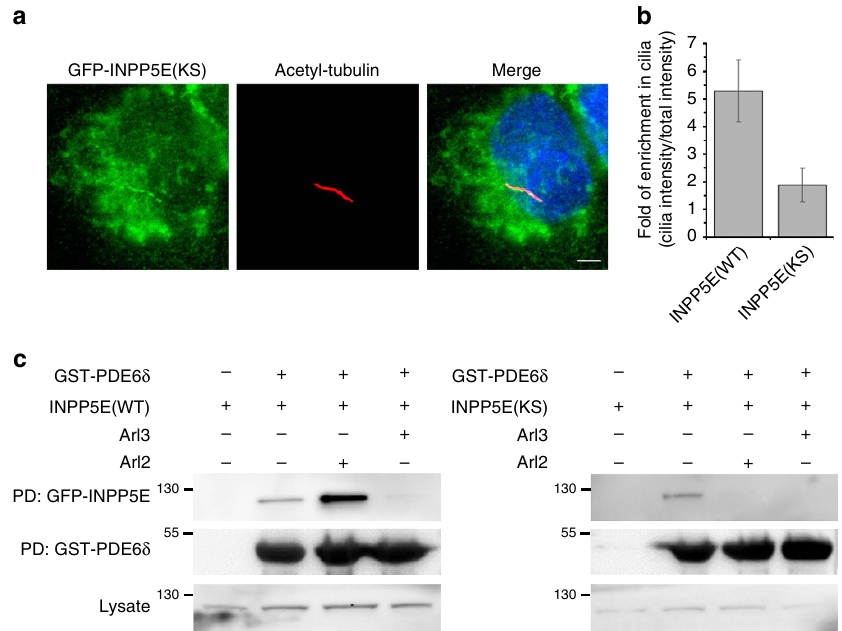
Figure 5 | INPP5E ciliary enrichment is dependent on high affinity to PDE6 d . ( a ) Localization of INPP5E(KS) mutant (green) in IMCD3 cells which were stably transfected with the GFP-tagged protein. White bar indicates 5 m m. ( b ) Bar chart showing ratio of GFP intensity in cilia to the total GFP intensity, indicating the enrichment of GFP-tagged protein in cilia. Data have been collected for 43 cells of INPP5E(WT) and 35 cells for INPP5E(KS) and analysis was performed using CellProfiler. Error bars indicate s.d., n Z 35 ( P o 0.05; Student’s t -test). ( c ) GSTpull-downs were performed using GST-PDE6 d along with the IMCD3 cell lysates stably expressing INPP5E(WT) (left) or INPP5E(KS) (right). Formed complexes in the pulldown experiment were incubated with Arl2 or Arl3 as indicated. The amount of GFP-tagged interacting proteins bound to GST-PDE6 d was detected by immunoblotting with an antibody against